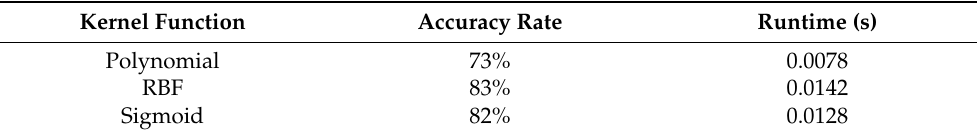
Table 1. The accuracy and runtime of the coal-gangue identification by SVM models with a different kernel